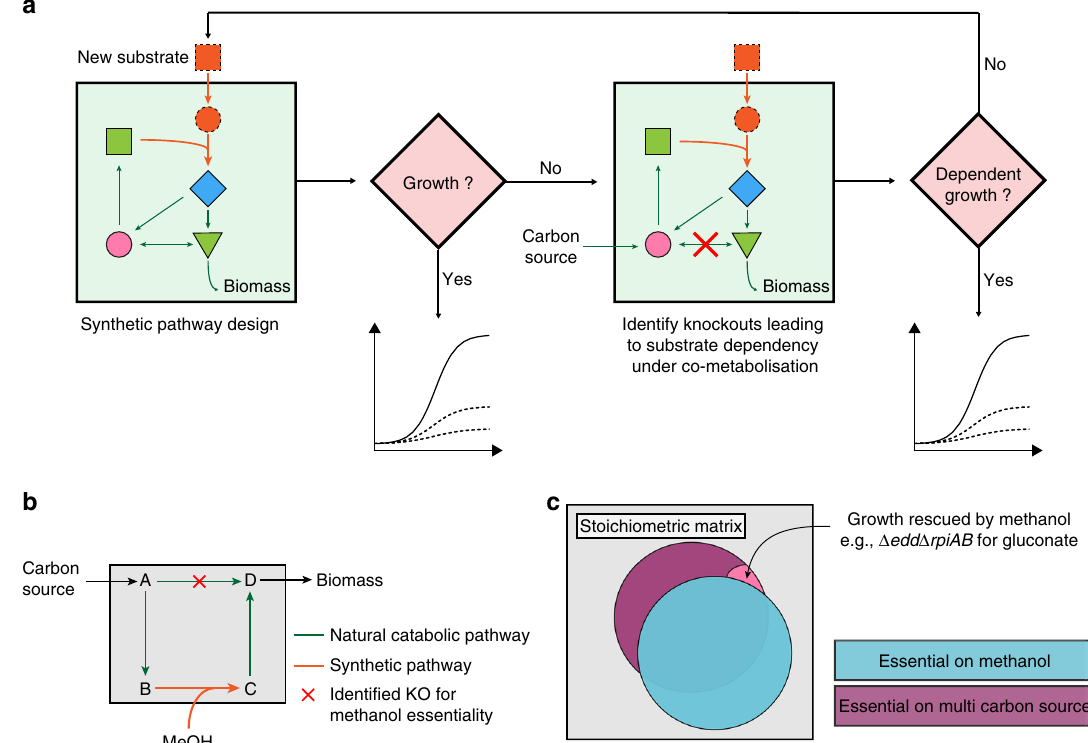
Fig. 1 Strategy for exogenous substrate utilization. a Introduction of a synthetic pathway is validated in silico, tested for growth, and optimized using adaptive laboratory evolution. If growth is not possible, substrate utilization is coupled to cellular fi tness under co-metabolization and optimized; otherwise, either pathway design is modi fi ed or new knockouts leading to substrate-dependent growth are tested. b Substrate (methanol) essential gene deletions are obtained by knockout of a natural catabolic pathway, thus allowing biomass formation only upon use of the synthetic methanol-dependent pathway. c Example of identi fi ed knockouts leading to methanol essentiality in the case of gluconate as a carbon